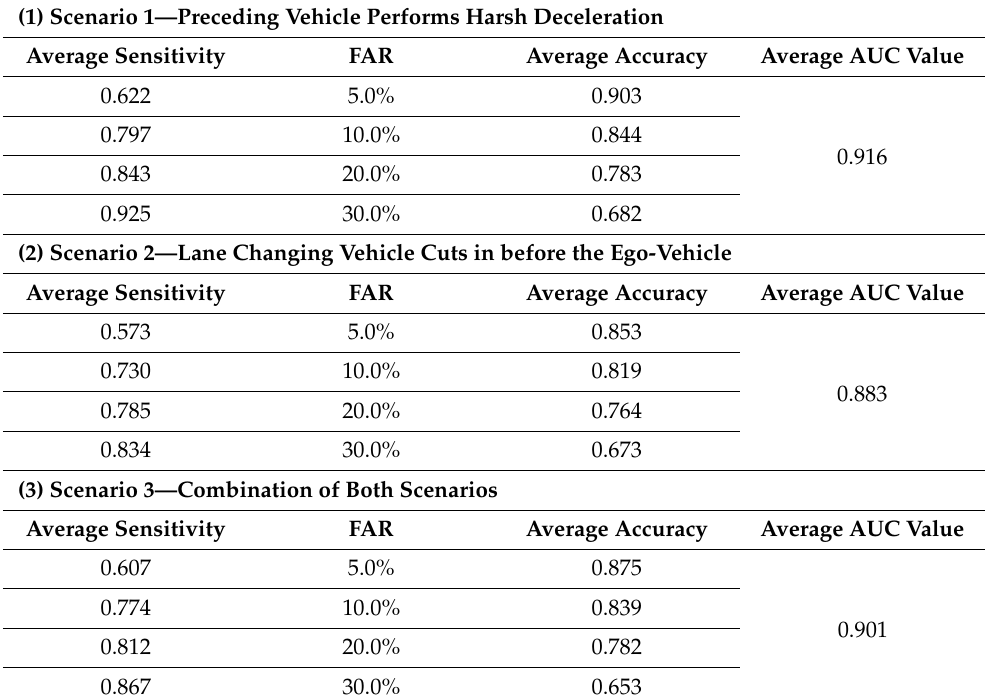
Table 4. Validation from PreScan of traffic conflict prediction algorithm in a virtual